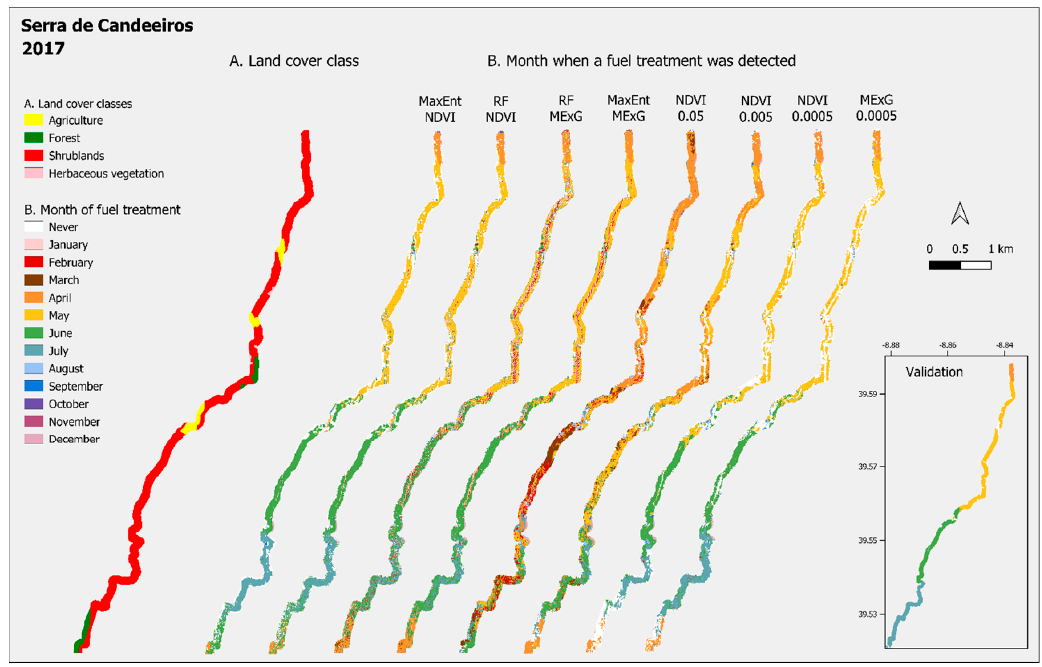
Figure 7. Results in Serra de Candeeiros in 2017: A. land cover; B. results from Method 1 and Method 2. The validation figure indicates the monthly fuel treatments assessed by image interpretation.